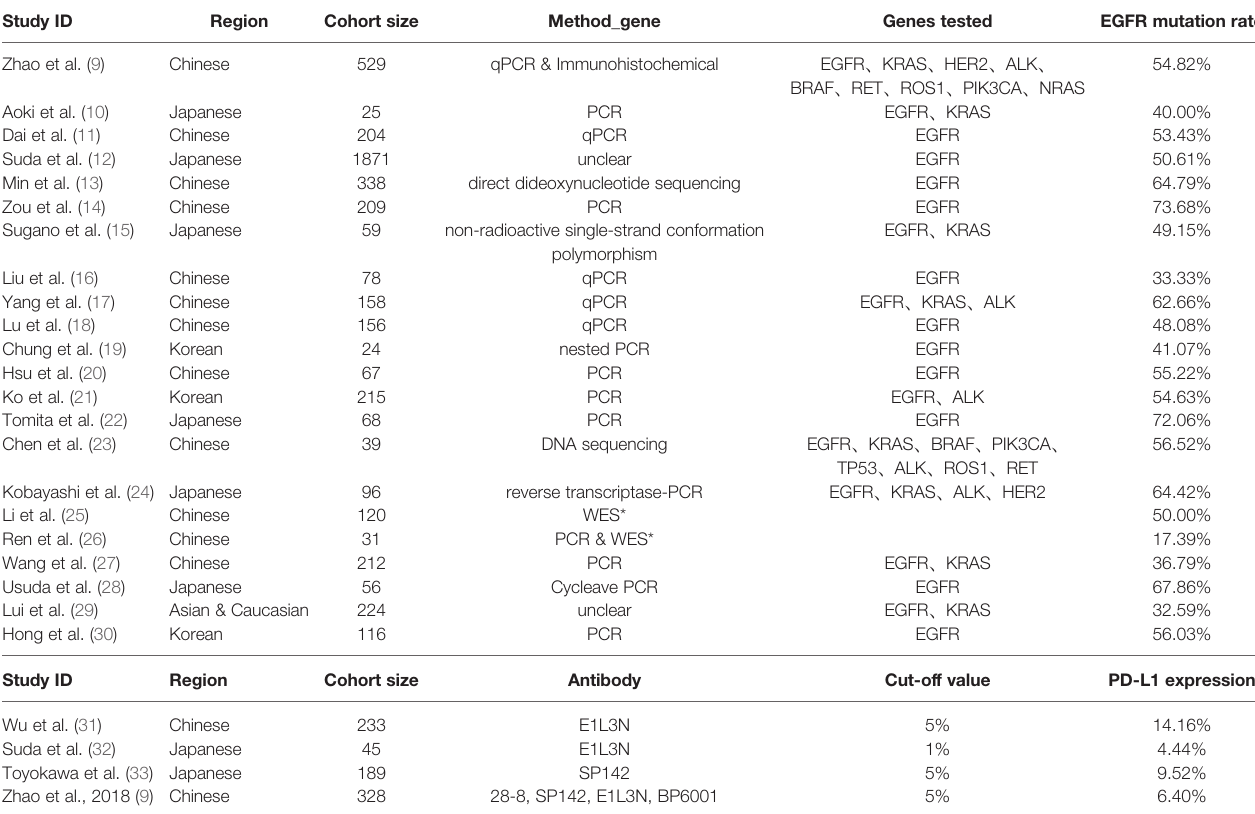
TABLE 1 | Characters of the studies included in the meta-analysis.